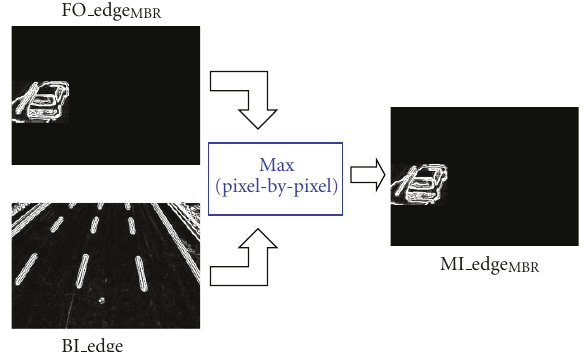
Figure 5: Max-operations and MI edge MBR .